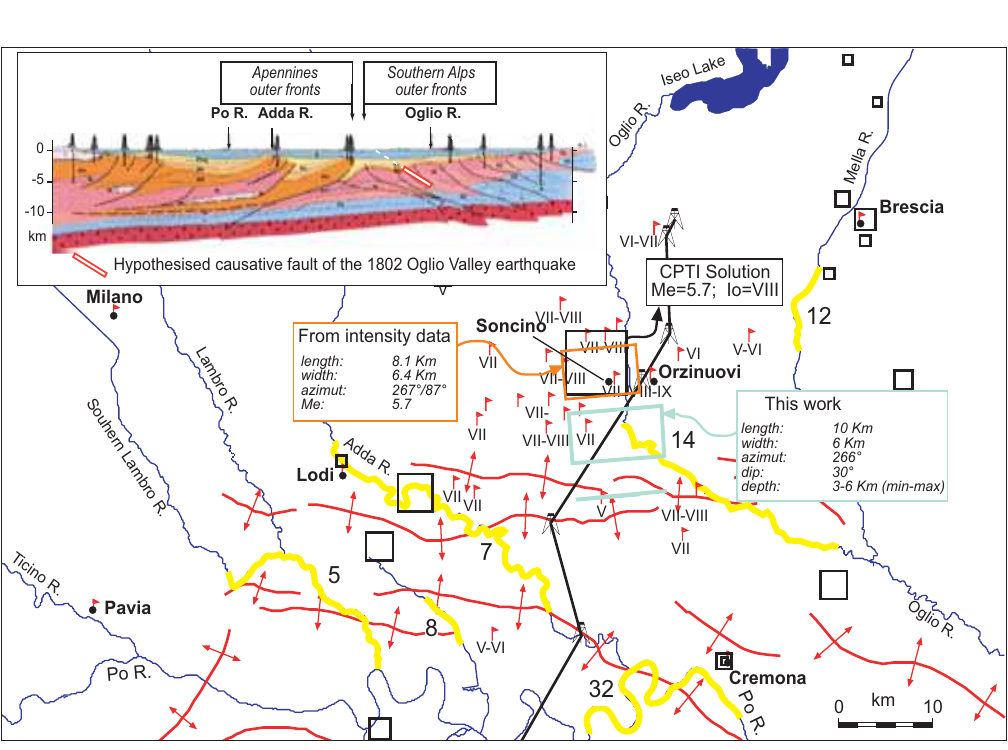
Fig. 7. Intensity data for the 12 May 1802, M e 5.7 earthquake (Boschi et al. , 2000), the Oglio River anomaly (# . 14), and buried anticlinal axes from geological maps. Two fault models respectively obtained from intensity data (using the Boxer code, Gasperini et al. , 1999) and geomorphological observations (this work) are shown for comparison. The black line is the trace of the geological section obtained from geophysical data shown in the upper left corner (from Cassano et al. , 1986, modified). It shows that in this area the south-verging Alpine front faces the north-verging Apennine outermost fronts. We propose that the seismogenic source of the 1802 earth- quake is a south-verging blind thrust fault belonging to the alpine